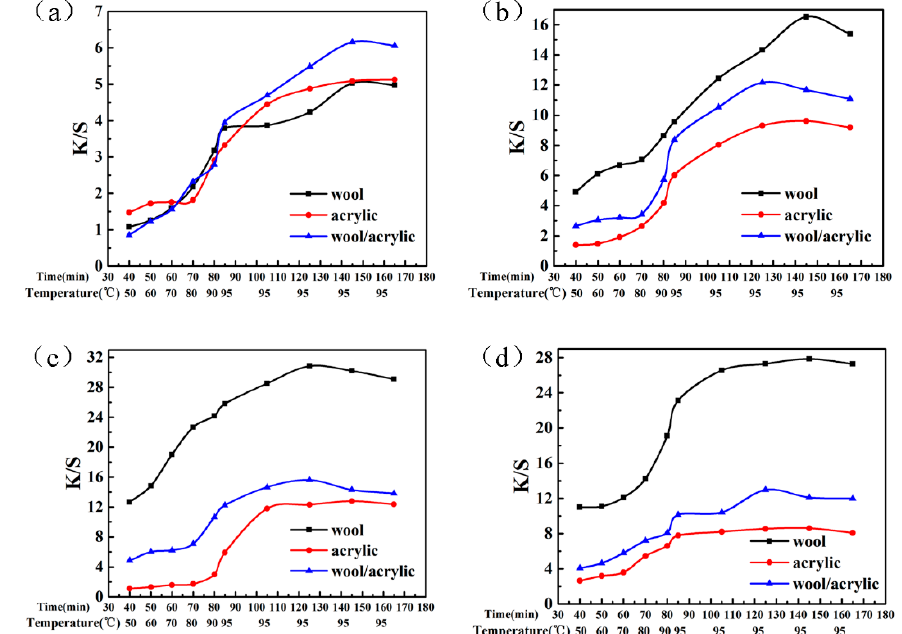
Figure 10. The dyeing heat-rate curve of the heterocyclic reactive dyes. ( a ) Dye 1; ( b ) Dye 2; ( c ) Dye 3; ( d ) Dye 4.